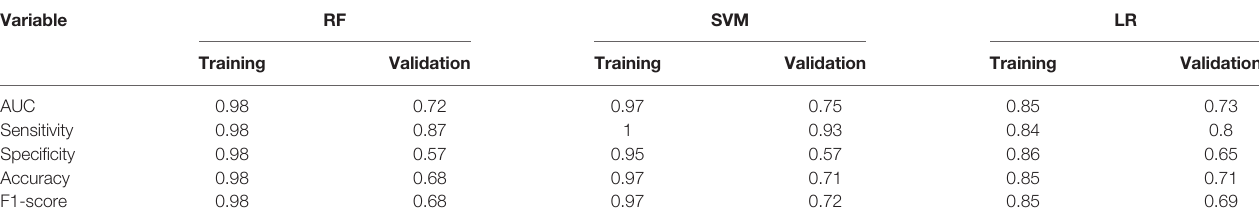
TABLE 3 | Comparison of the three radiomics feature classi fi ers.